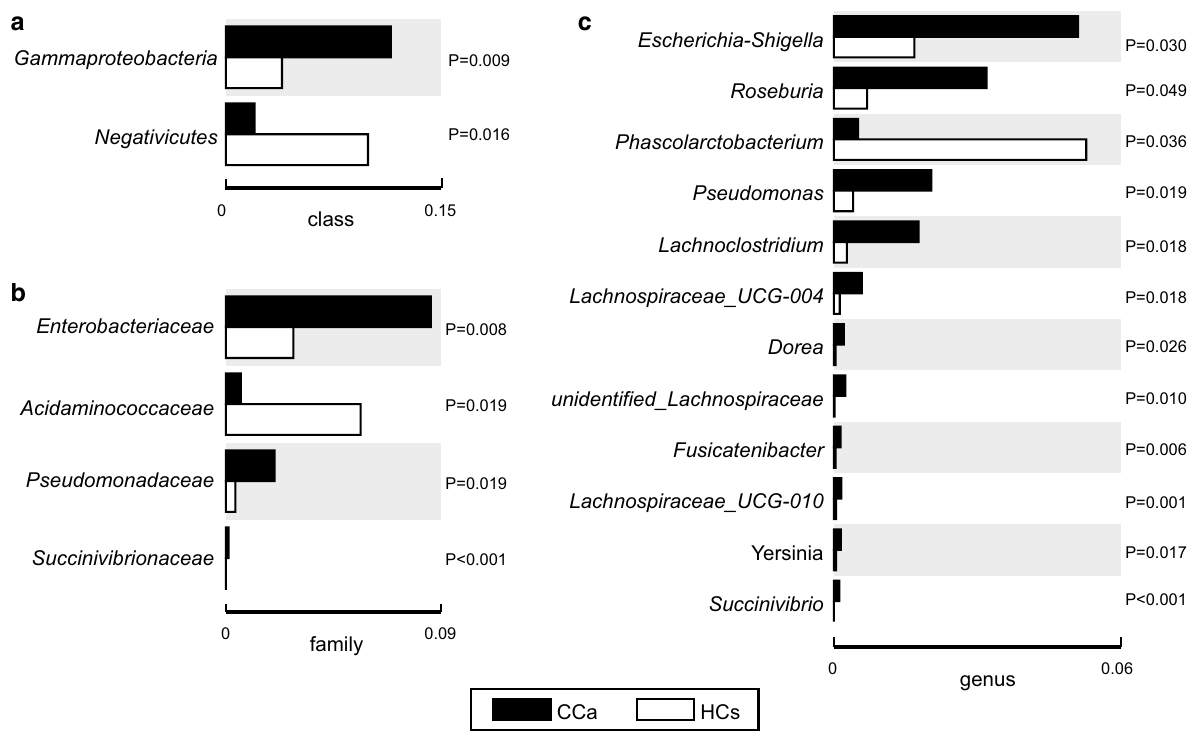
Fig. 4 Boxplots representing the average proportion of each 16S sequence read attributed to each taxon. a on the class level, b on the family level, c on the genus level ( White healthy control samples, Black patient samples )